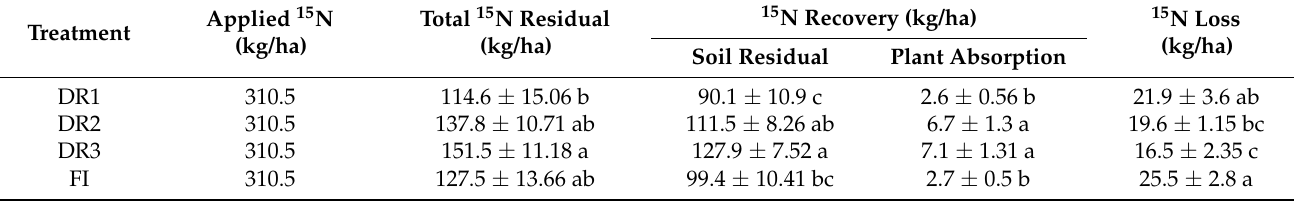
Table 2. The fate and balance of 15 N under different irrigation modes.